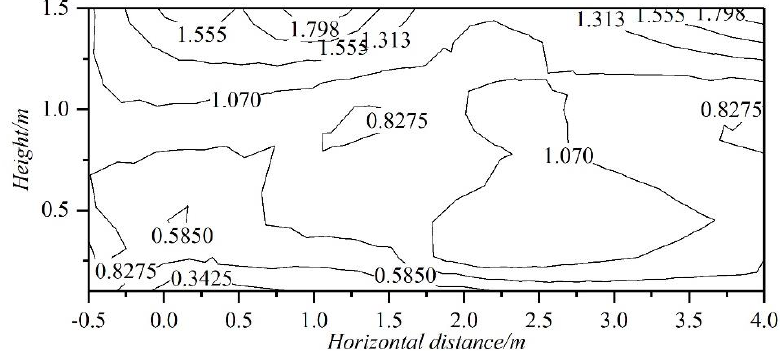
Figure 4. Airflow distribution at different heights behind 1-m-high H. rhamnoides (contour value was V n /V m , V n is wind velocity of mobile points at different positions around plants, V m is wind speed at the standard point) .